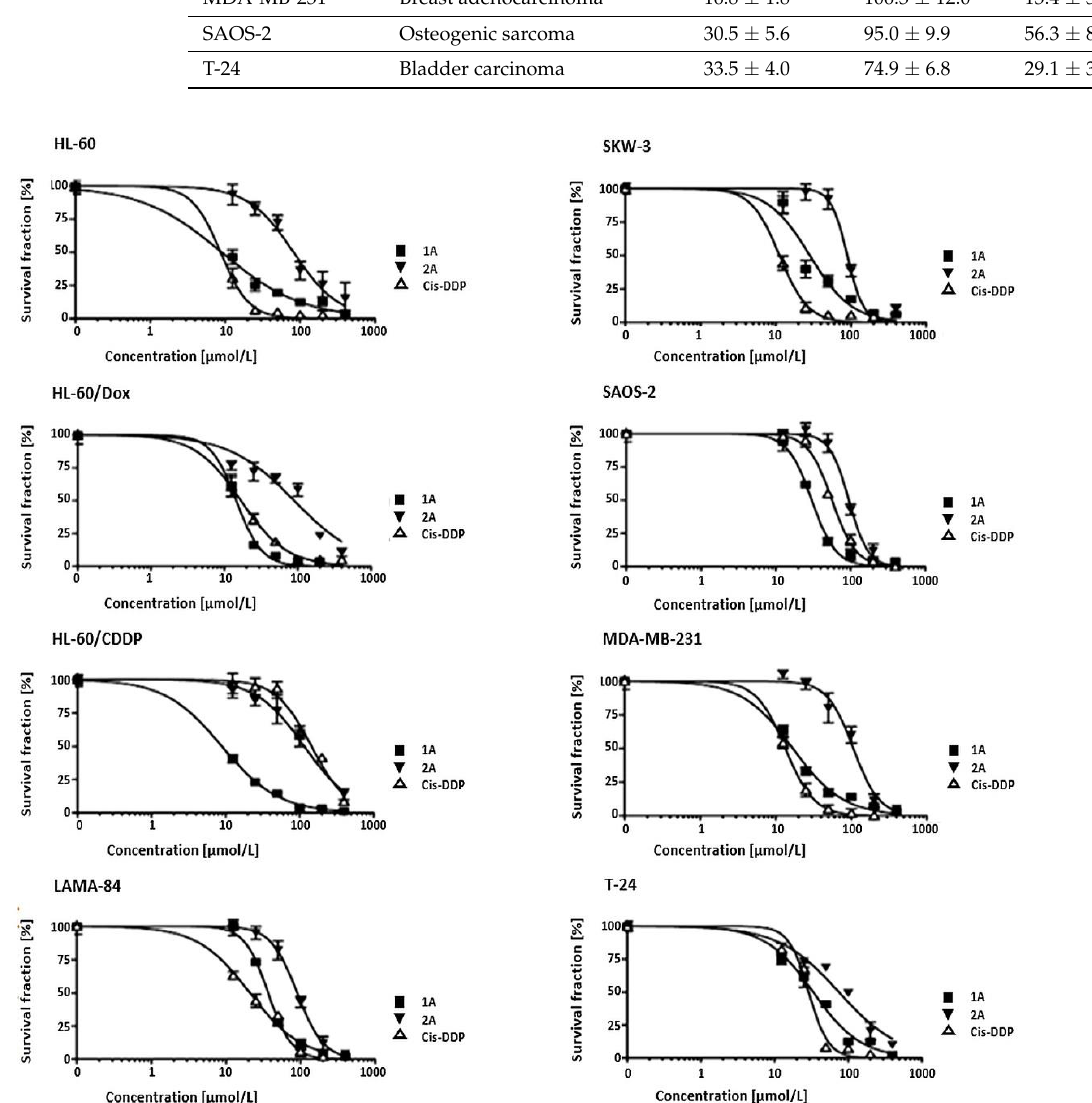
Figure 7. Cell growth inhibitory effects of complex 1A , complex 2A vs. cisplatin against a panel of human tumor cell lines after 72 h continuous exposure (MTT-dye reduction). Each data point represents the arithmetic mean ± sd of 8 separate experiments.